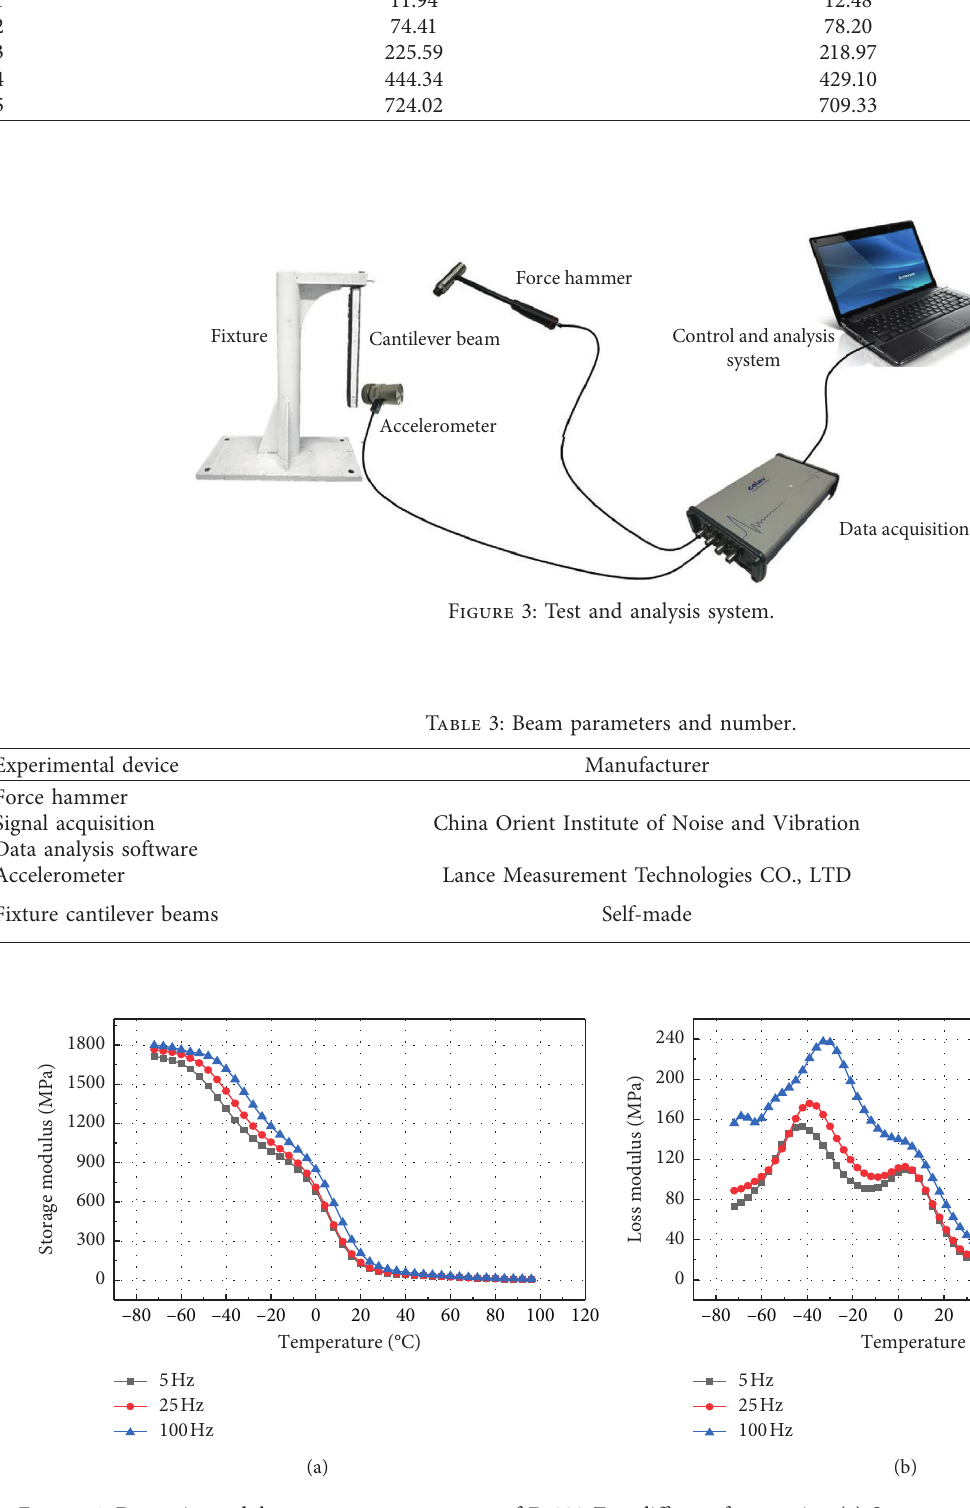
Figure 4: Dynamic modulus temperature spectrum of D-803-Z at different frequencies. (a) Storage modulus. (b) Loss